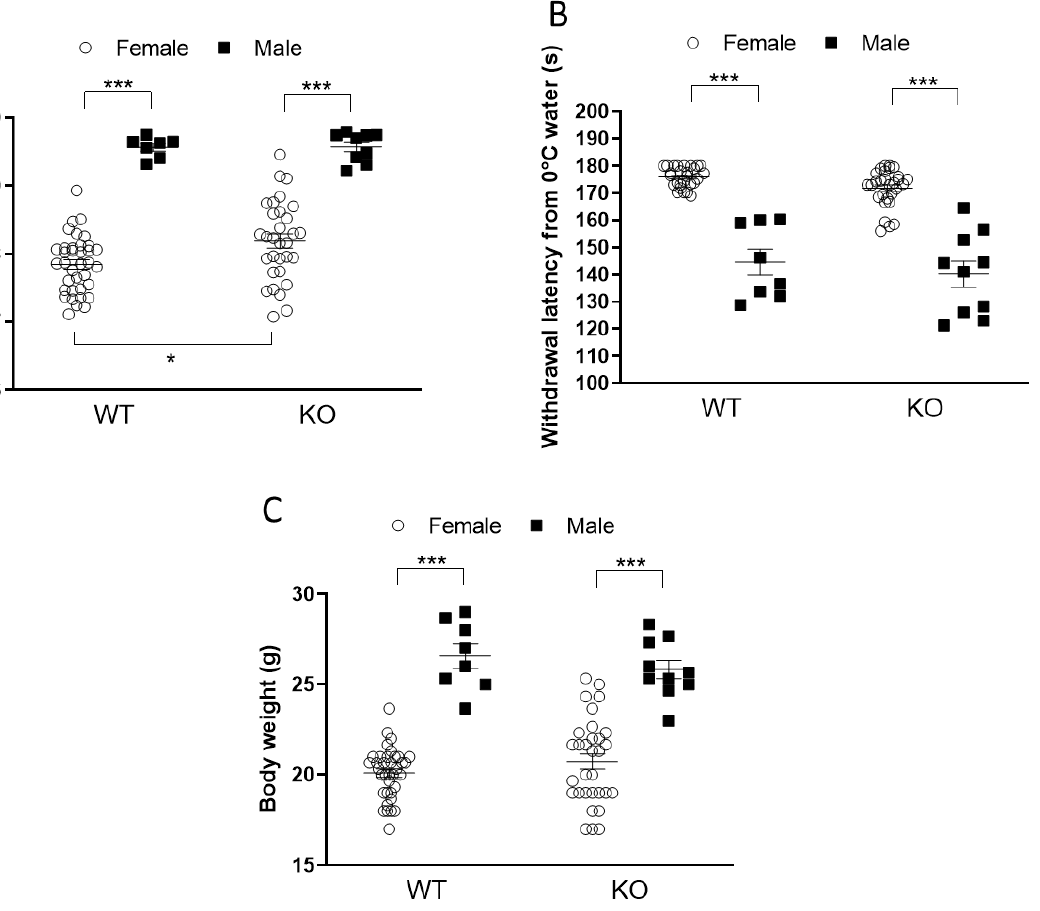
Figure 1. Baseline mechanonociceptive threshold ( A ), cold tolerance ( B ) and body weight ( C ) values of female and male wild-type (WT) and Interleukine-1-deficient (knock-out: KO) mice at the beginning of the experiment. Data are presented as the means ± SEM of n = 7–36 animals with individual plots (female WT: 36; female KO: 31; male WT: 7; male KO: 9); two-way analysis of variance (ANOVA), followed by Tukey’s tests; * p < 0.05, *** p < 0.0001 vs. indicated groups.